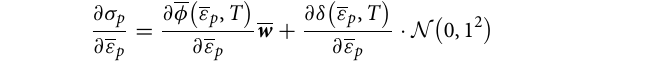
The yield function with the HSGPR-based flow stress model is called at each increment of the FEA to check the yield state of each element integration point and update the flow stresses of the element integration points which have reached plasticity. In order to update the flow stresses, the stiffness of the HSGPR-based flow stress model, that is the gradient of the flow stress model σ p with respect to the equivalent plastic strain ε p and tem- perature T , respectively, is queried in the FEA 32 . The corresponding stiffness (i.e. ∂σ p /∂ε p and ∂σ p /∂ T ) of the HSGPR-based flow stress model is expressed as: